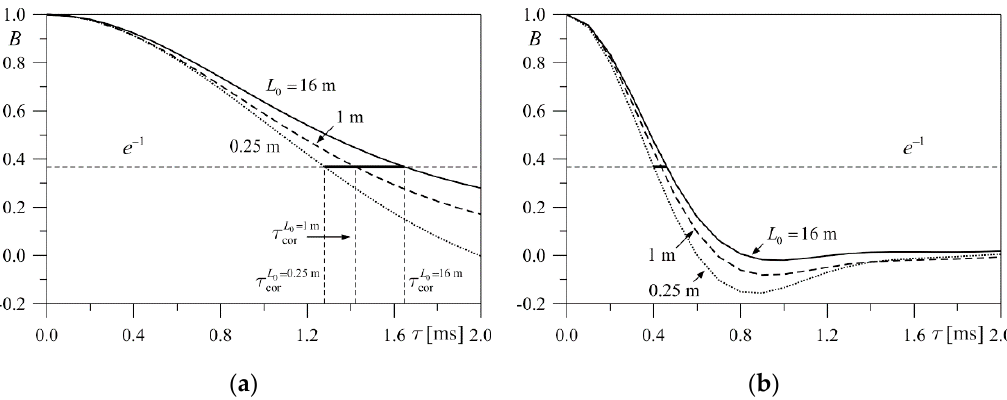
Figure 6. Autocorrelation function B ( τ ) computed for a single turbulence layer of strength C 2 n = 10 − 15 m − 2/3 ( r 0 = 16.3 cm), different outer scale values, L 0 = 16 m (solid lines), L 0 = 1 m (dashed lines), and L 0 = 0.25 m (dotted lines), and different turbulence layer positions: ( a ) z / L = 0.1; ( b ) z / L = 0.3. Here, the diameter of the TILAS transceiver aperture d TILAS = 7 cm; other parameters are the same as in Figure 3.